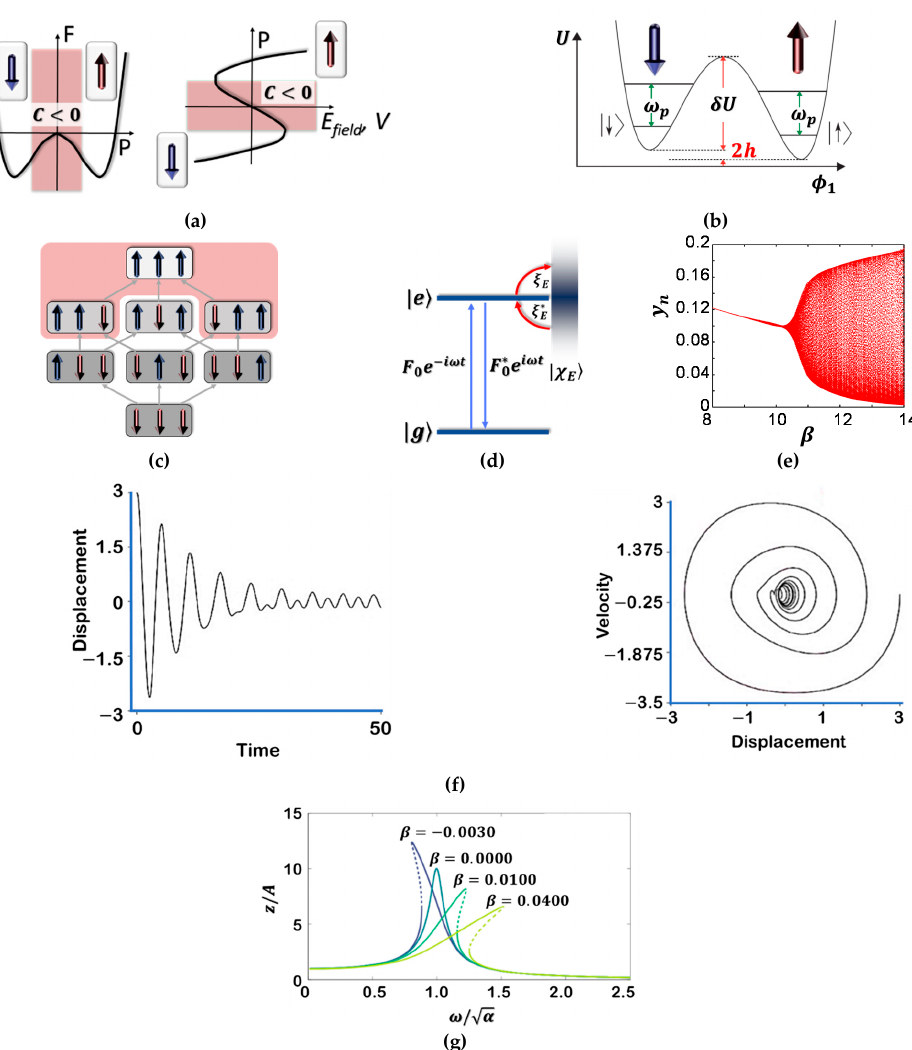
Figure 1. Ferroelectric, ferromagnetic, qubit, Ising model, Rabi oscillation, bifurcation, and damped-forced oscillator. ( a ) Landau–Ginzburg–Devonshire model for a ferroelectric. Left, the double-well free energy F in a ferroelectric as a function of the electric polarization P. Red shading denotes regions of negative capacitance (C < 0). Right, ferroelectric polarization– electric field / potential difference dependence obtained from the free energy F. The ‘S’-shaped P vs E Field curve displays a region of negative capacitance related to the energy barrier of F. Arrows indicate ferroelectric polarization directions; ( b ) Double-well potential energy diagram and the lowest quantum energy levels corresponding to the qubit. States | ↑ > and | ↓ > are the lowest two levels, respectively. The intra-well energy spacing ω p . The measurement detects magnetization and does not distinguish between, | ↑ > and excited states within the right-hand well. These excitations are exceedingly improbable at the time the state is measured [10]. ( c ) Minimal superatom with three spins. The configurations are coupled by spin-flips with coupling Ω (grey arrows). The interaction energy of each state is indicated by the brightness of the grey background. When selecting states with a minimal distance between spin ↑ , all states in the red shaded area are neglected. While the coupling from the ground state ∣ ↓↓↓ > to the states with n ↑ = 1 is spatially homogeneous, the coupling of the singly excited states to the state with n ↑ = 2 is spatially inhomogeneous [6]; ( d ) Fouquet states; model of a harmonically time-varying classical field of amplitude |F 0 | that couples the ground state |g> to the excited state |e> of a two-level system, which itself is coupled to a continuum of states | χ E > [14]; ( e ) Bifurcation diagram for y n [33]; ( f ) Duffing oscillator; displacement vs time and velocity vs displacement (phase portrait) [34]; ( g ) Frequency response z / A as a √ α for the Duffing equation, with α = A = 1 and damping δ = 0.1 (Equation (1)). The dashed parts of the function of ω / frequency response are unstable [35]. All the graphs cited were adapted from the